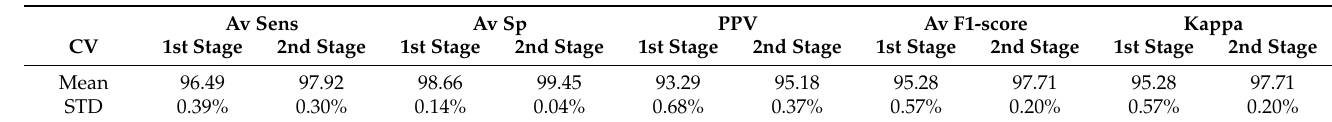
Table 13. Evaluation of the average accuracy through Sens, Sp, PPV, F1-score, and kappa with cross-validation in the first and second stages.